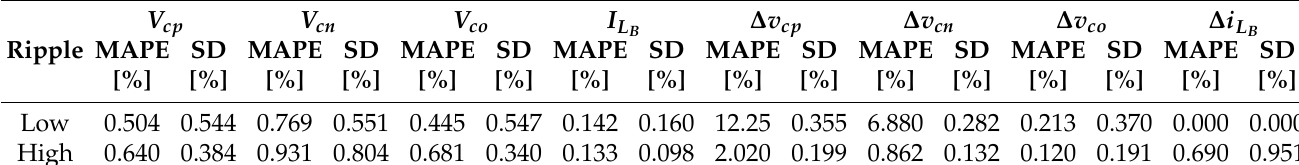
Table 4. Percentage error statistical results of the proposed converter with Ripple